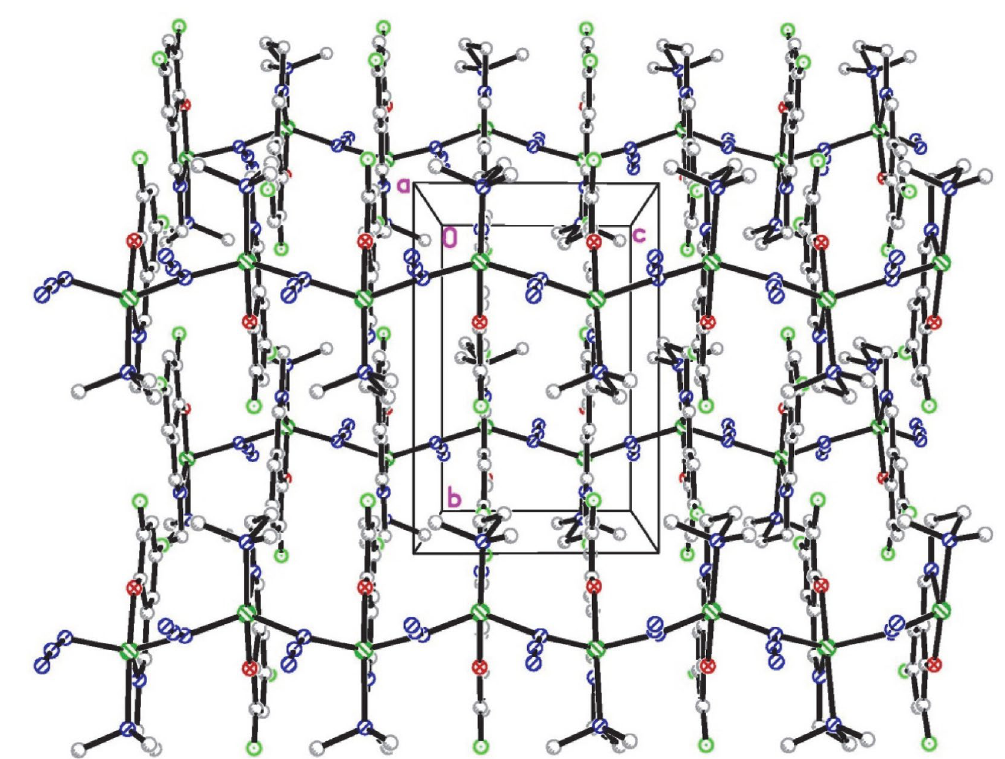
Figure 4. The end-on azido bridged polynuclear structure of complex 2 , viewed along the axis- a